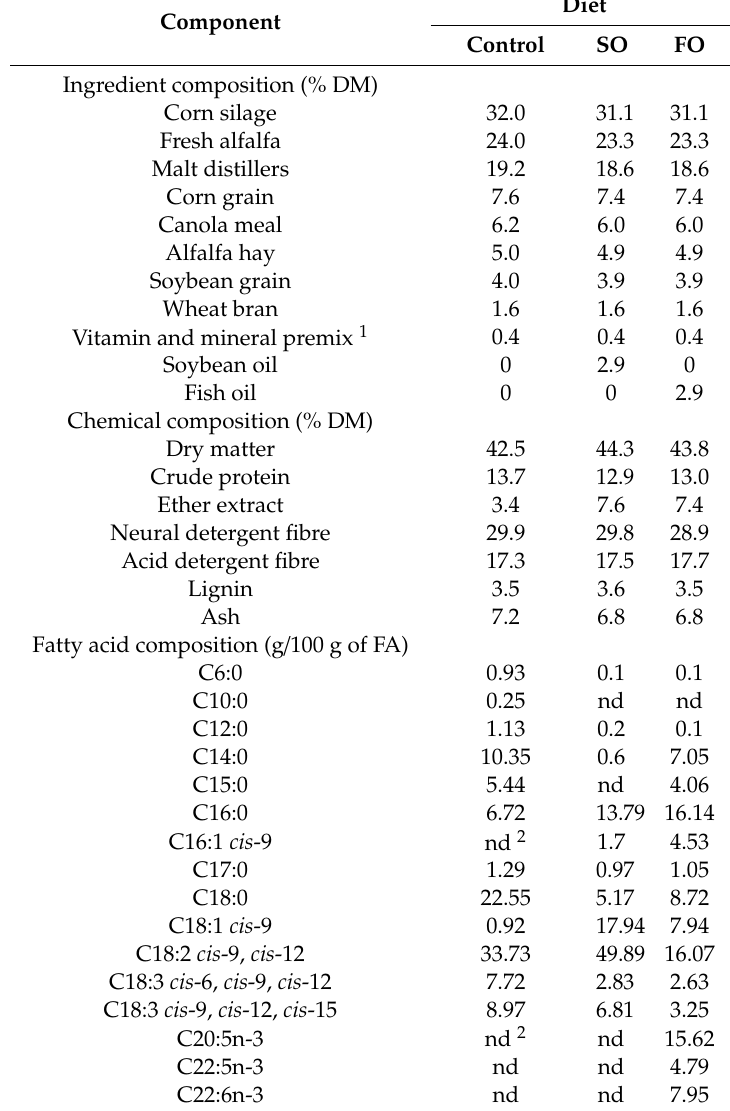
Table 1. Ingredient and chemical composition of control, soybean oil (SO), and fish oil (FO) dietary treatments. Diet Component Control SO